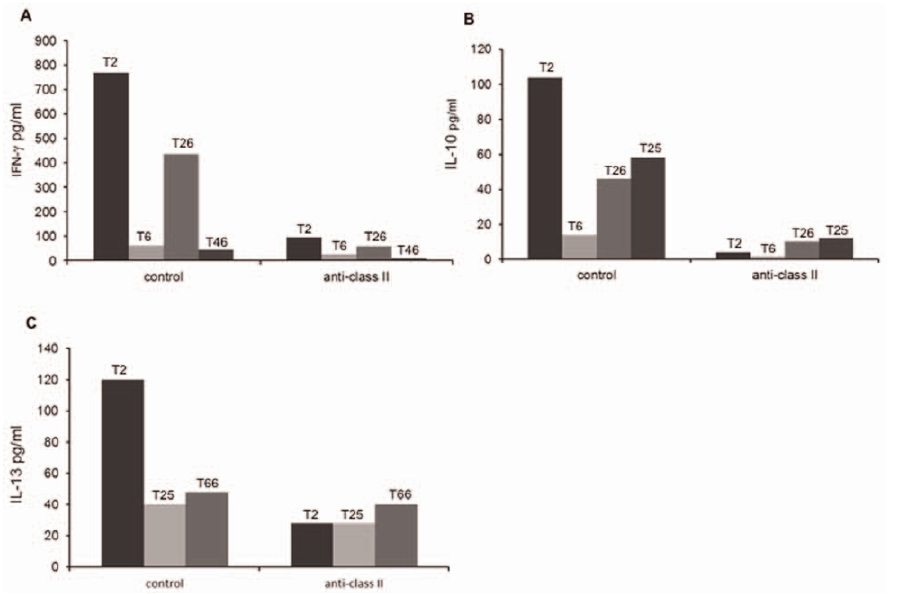
Figure 4. Effect of HLA class II-specific monoclonal antibodies on TSV-VP1 specific cytokine responses. PBMC of TSV seropositive individuals were incubated with HLA class II-specific monoclonal antibody and with a isotype-matched contol antibody (MAbs) and stimulated with TSV-VP1 for IFN- c (A), IL-10 (B) and IL-13 (C) assessment.